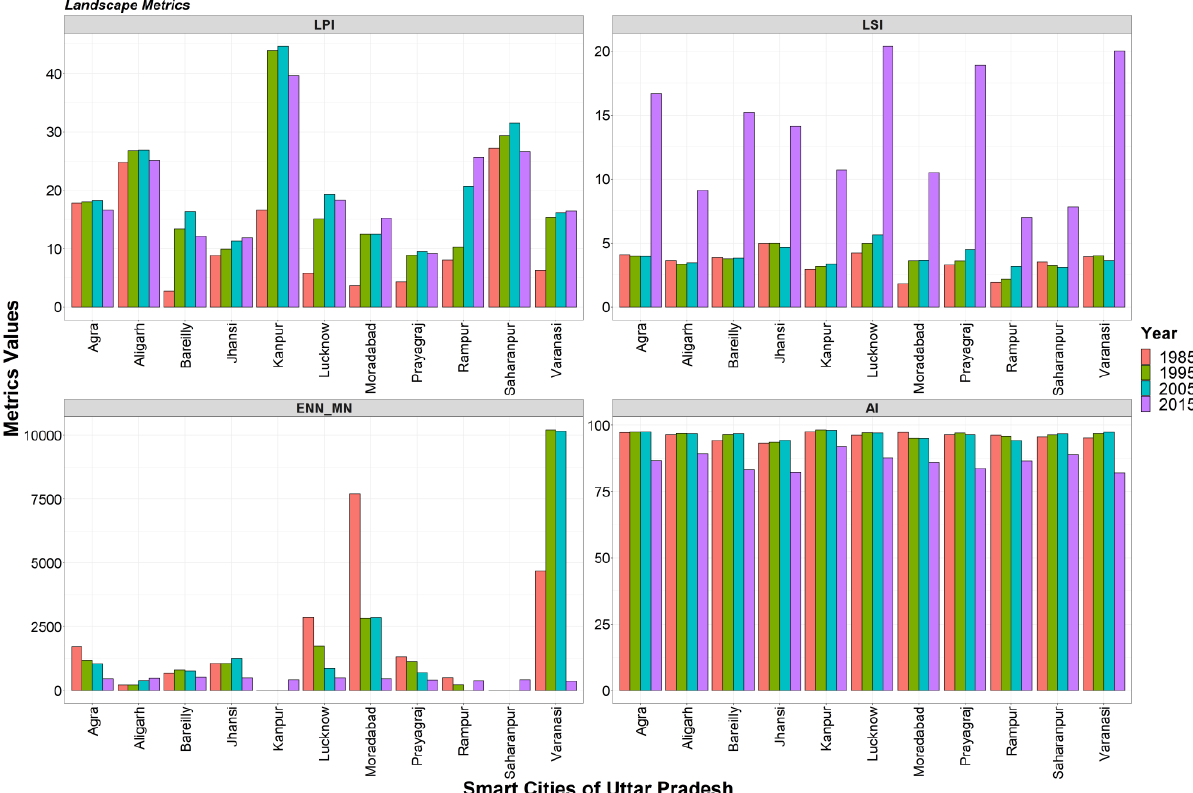
Figure 5. Landscape Metrics for Built-up